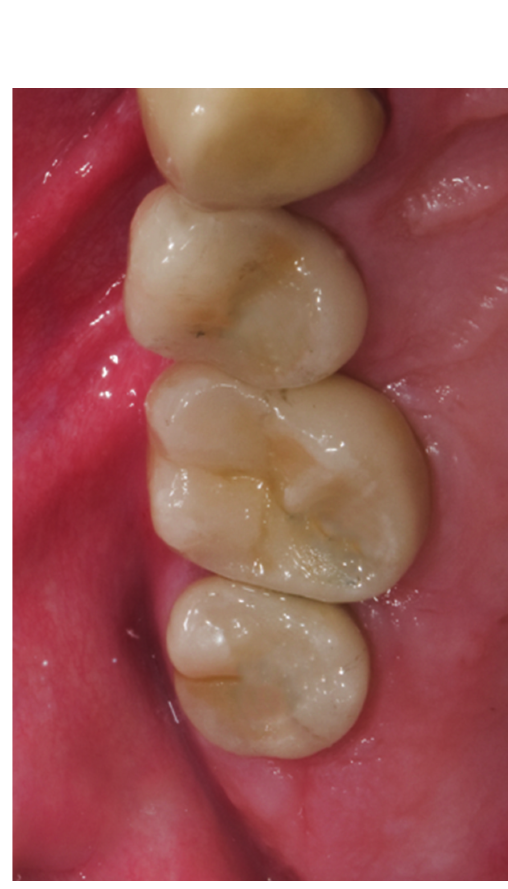
Figure 7: Second surgical phase.